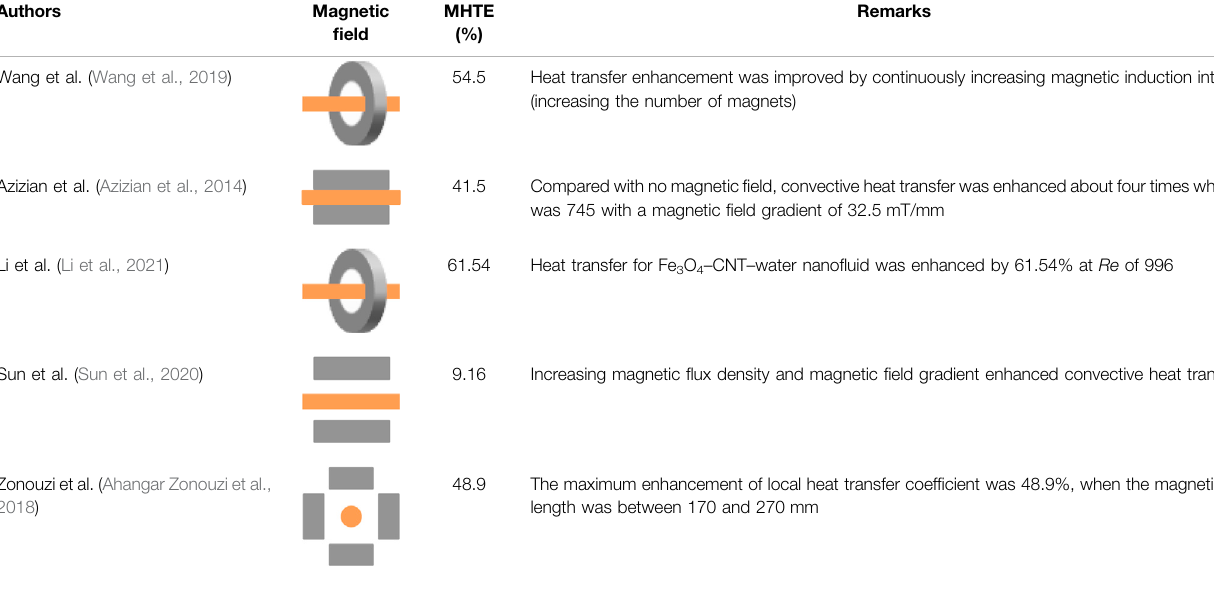
TABLE 10 | Thermal performance of magnetic fl uids in straight tubes under magnetic fi